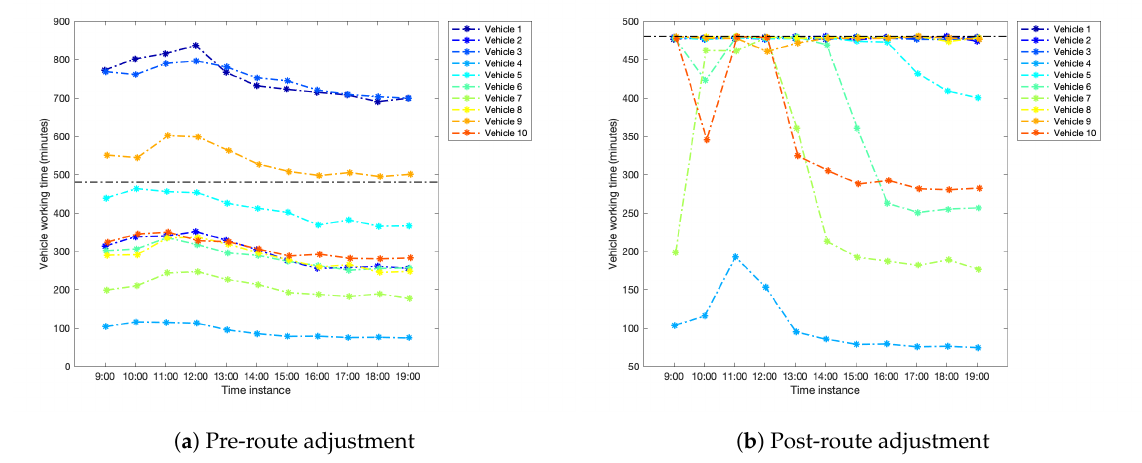
Figure 5. Pre- and post-route adjustment obtained before and after applying Algorithm 2 for problems in Scenario A at time instances between 9 a.m. and 7 p.m. The black dashed line displays the working time limit of 480 min.